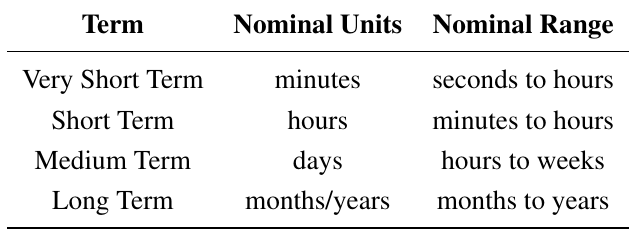
Table 2. Nominal terminology for the time frames of energy forecasting and